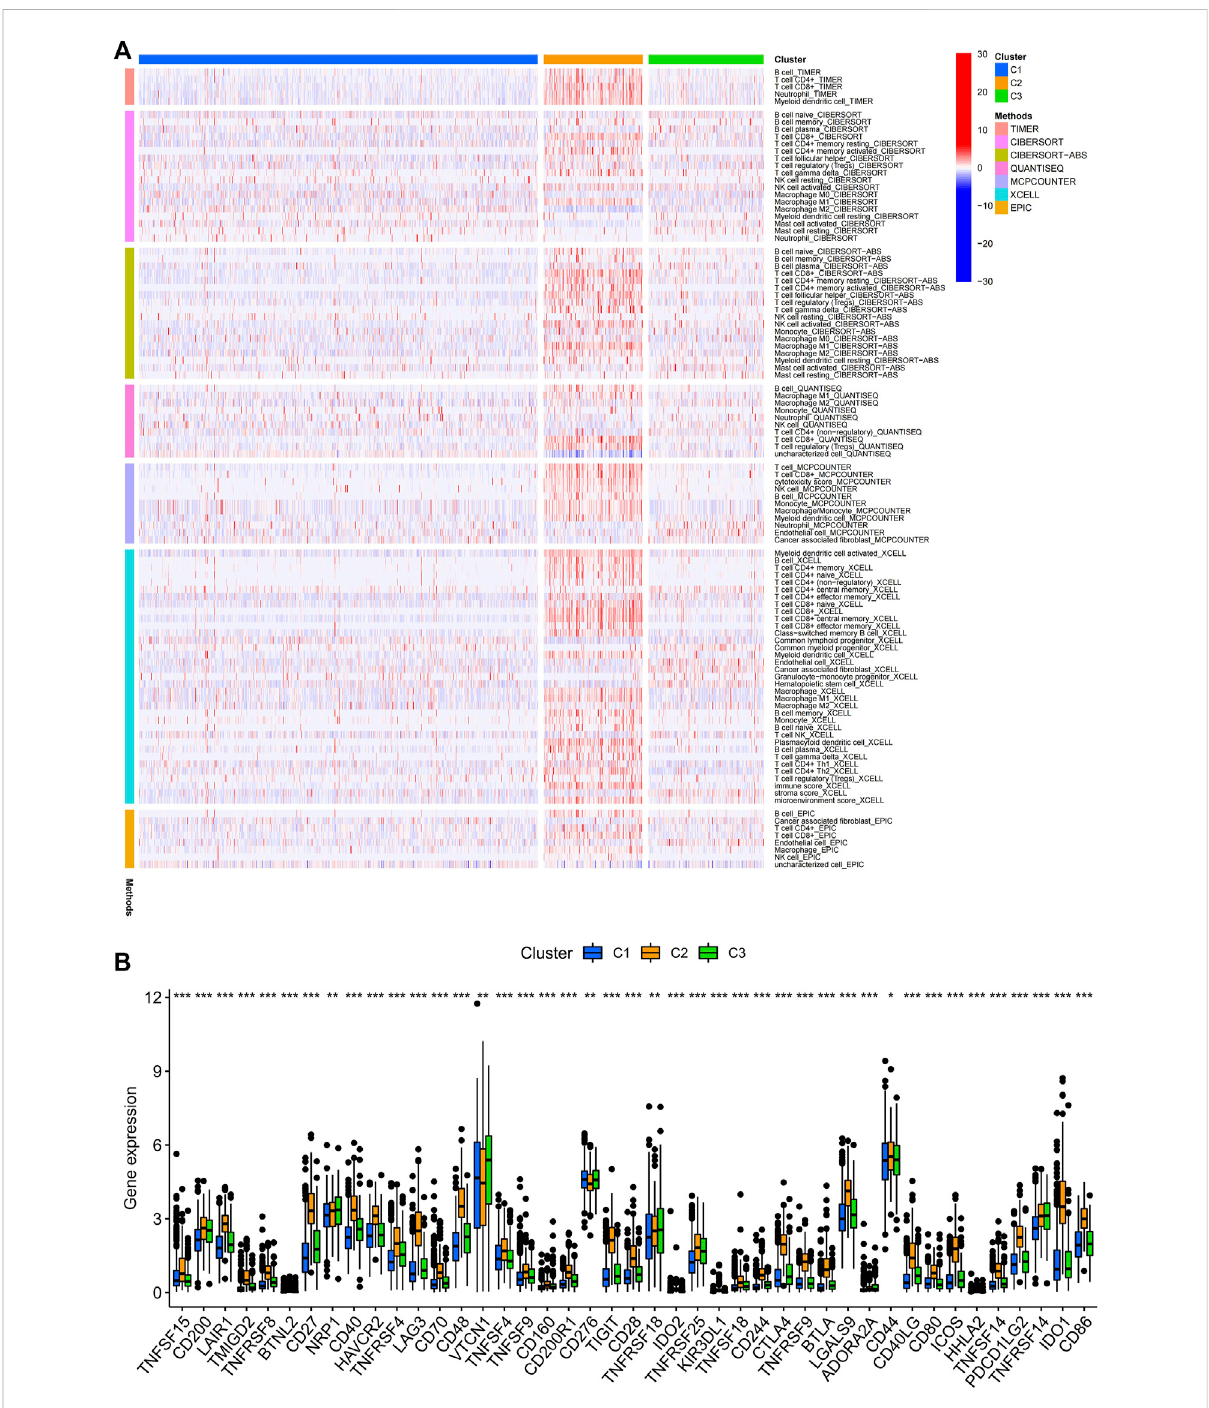
FIGURE 8 In fi ltration of immune cells and the expression of immune checkpoints among the three different subgroups of BC. (A) Estimation of immune- in fi ltrating cells by using the Spearman correlation analysis with multiple algorithms among the three different subgroups. (B) Differential expression analysis of 43 immune checkpoint genes among the three different subgroups. BC, breast cancer; *, p < 0.05; **, p < 0.01; ***, p <